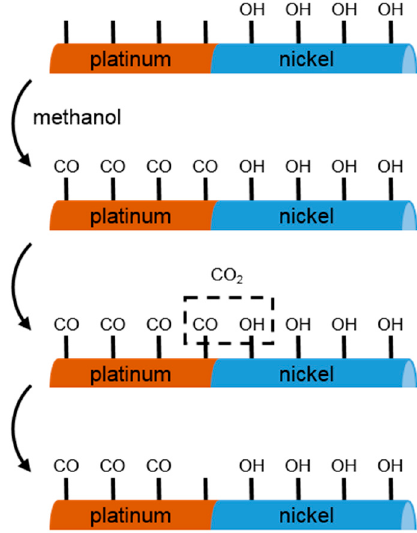
Figure 2. Illustration of the platinum reactivation process by nickel for the catalysis of methanol. The surface of the native oxide on top of the nickel segment is covered by hydrogen oxide groups (OH) in an aqueous dispersion. In the presence of methanol, the reaction sites on the platinum segment will be occupied by carbon monoxide species (CO). These CO groups react with the neighboring OH groups to form carbon dioxide (CO 2 ). The result is that the reaction site on the platinum is available for the next reaction. Adapted figure from [51] with permission from copyright (2004) American Chemical Society (Washington, DC, USA).